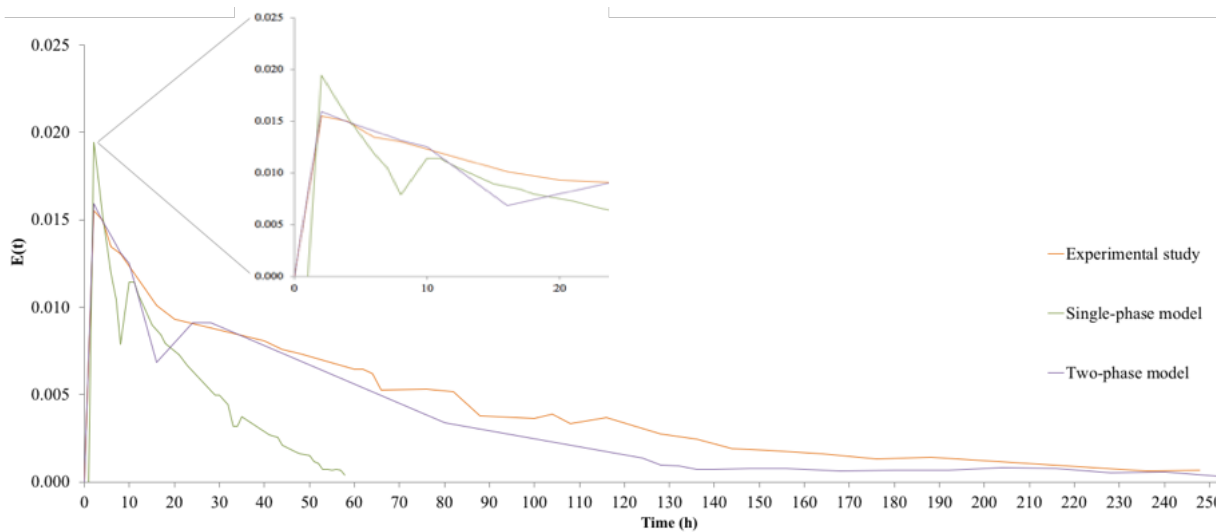
Figure 2. Residence time distribution obtained experimentally and with the CFD models (single-phase and two-phase).